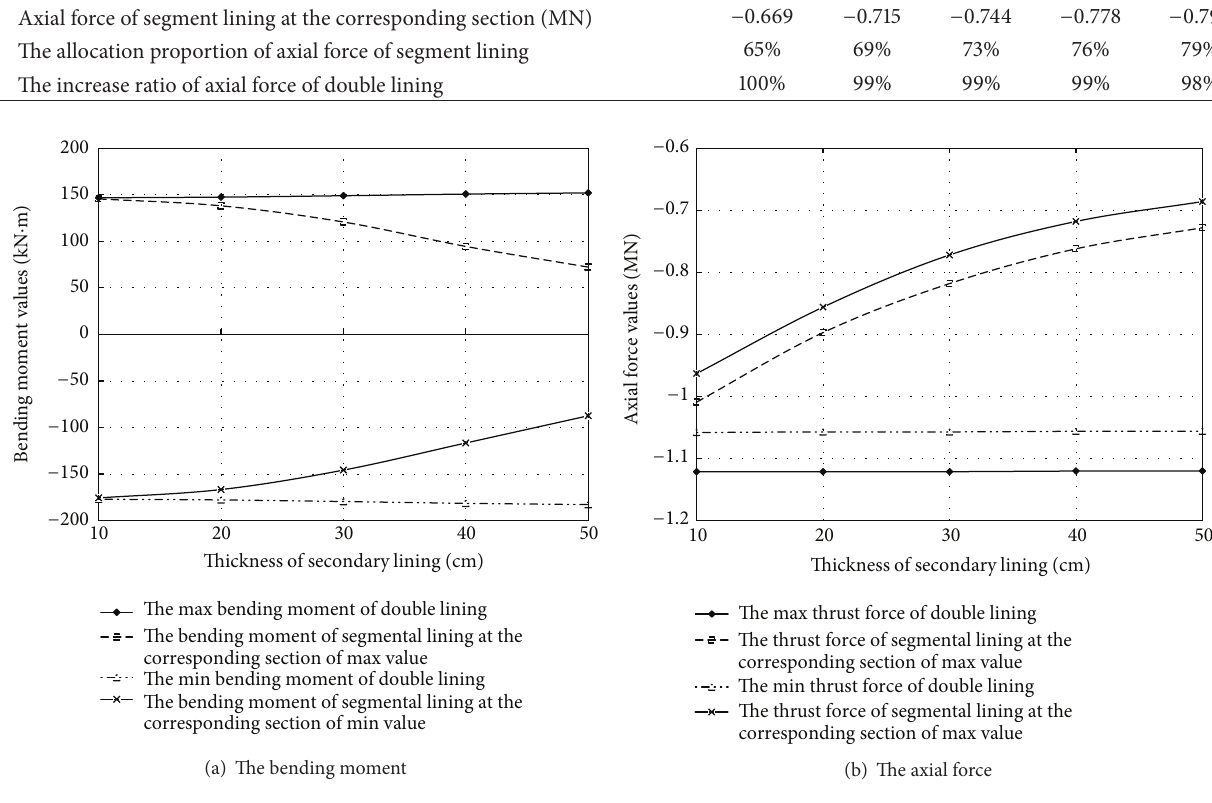
Figure 14: Numerical results of double lining under different thicknesses of secondary